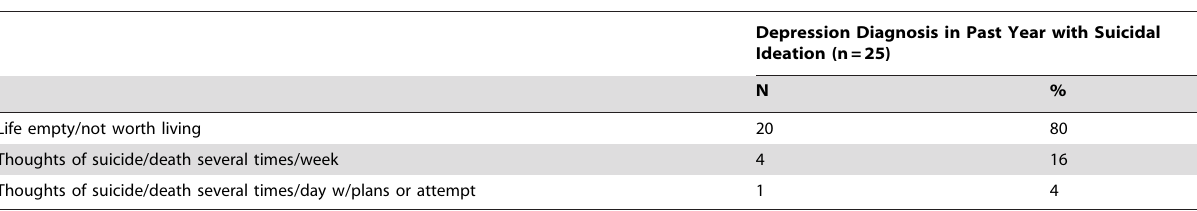
Table 4. Description of Suicidal